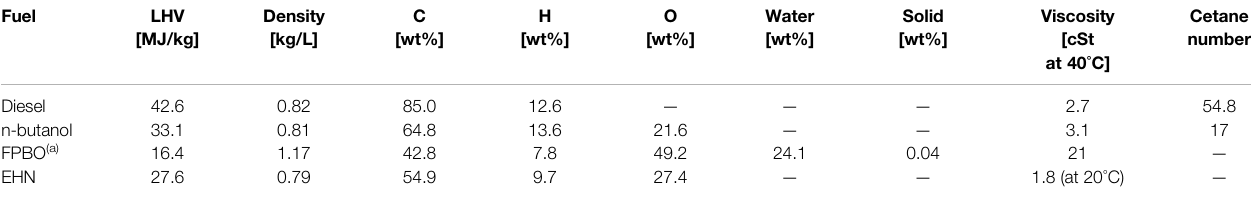
TABLE 3 | Fuel properties of diesel, n-butanol, FPBO and EHN.